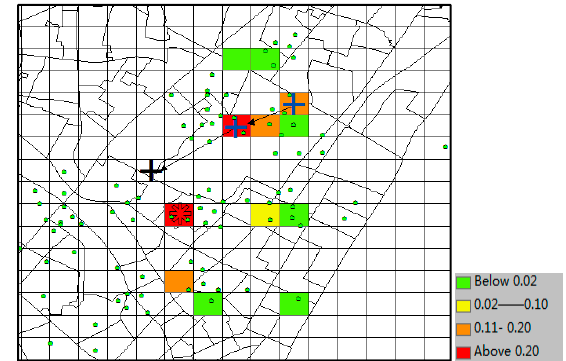
Figure 17. Result of SubSyn.